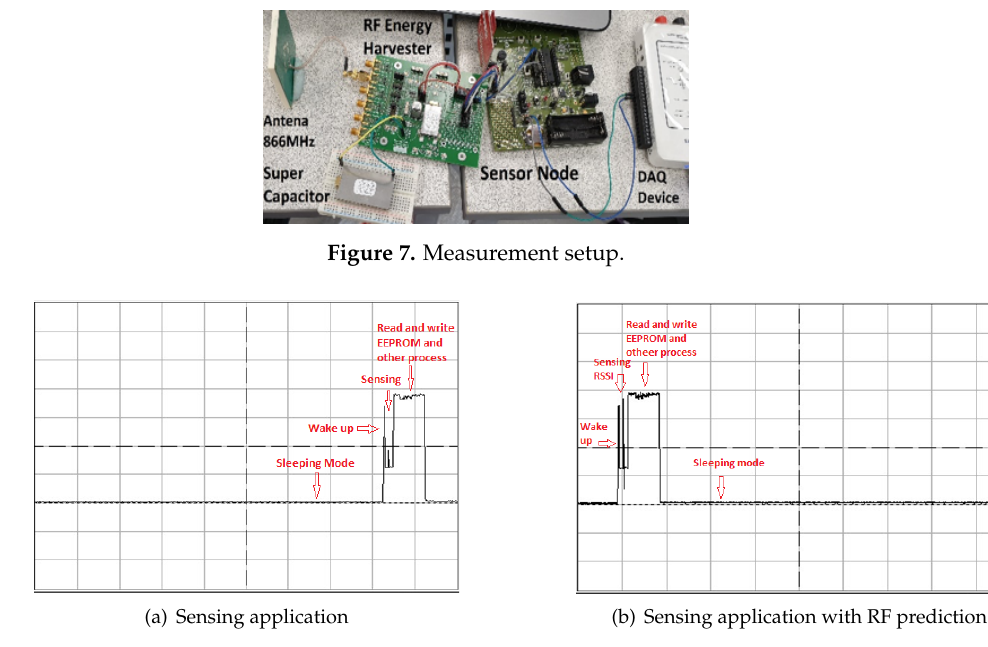
Figure 8. Oscilloscope screenshot for the energy profile of a simple application and the prototype. The oscilloscope was set at 20 mV/div with a timebase of 10 Figure 1: Energy used by sensor node in different modes when running a simple application The energy consumption of the sensor node is measured by myDAQ (data acquisition device) from national instruments as oscilloscope. A simple application, waking up in every 5s sensing temperature and saving the value in the EEPROM, consumed 7.93X10 -5 J as shown in Fig.1